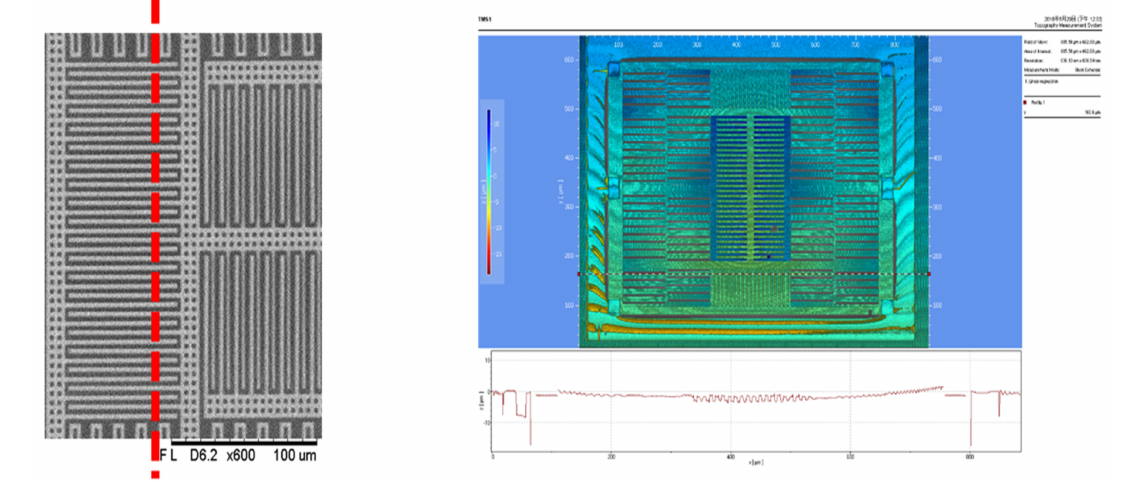
Figure 25. Surface height measurements of the sensing electrodes along the X -axis. Figure 26a,b show the frequency response of the motion along the X - and Y -axis, respectively. The resonance frequency of the X -axis and Y -axis motion were 3.9 kHz and 7.8 kHz. Moreover, the resonance frequency of the Z -axis motion was 7.7 kHz measured by a laser Doppler vibrometer as shown in Figure 26c. In the chip, for resonance frequency, errors between the simulator and measurement were all below 5.28%.